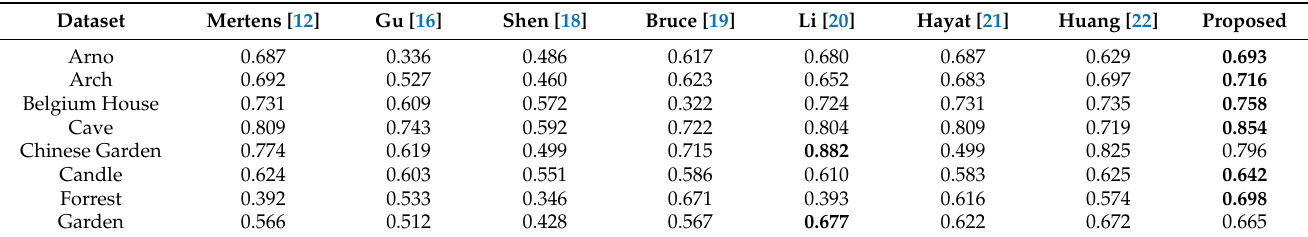
Table 6. The test result of indicator Q AB / F